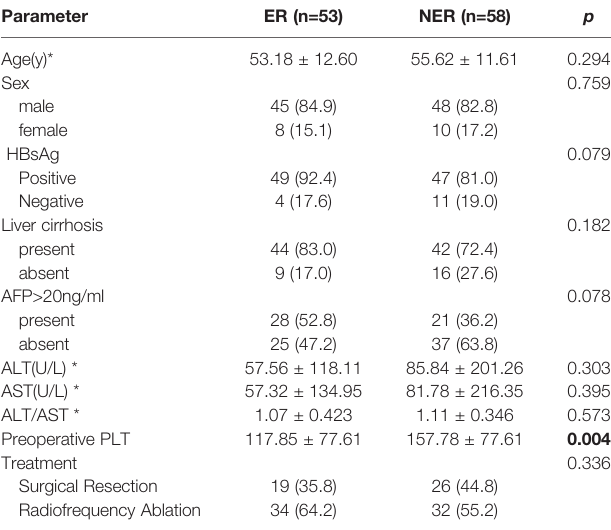
TABLE 1 | Baseline characteristics of ER and NER groups in the study population. Parameter